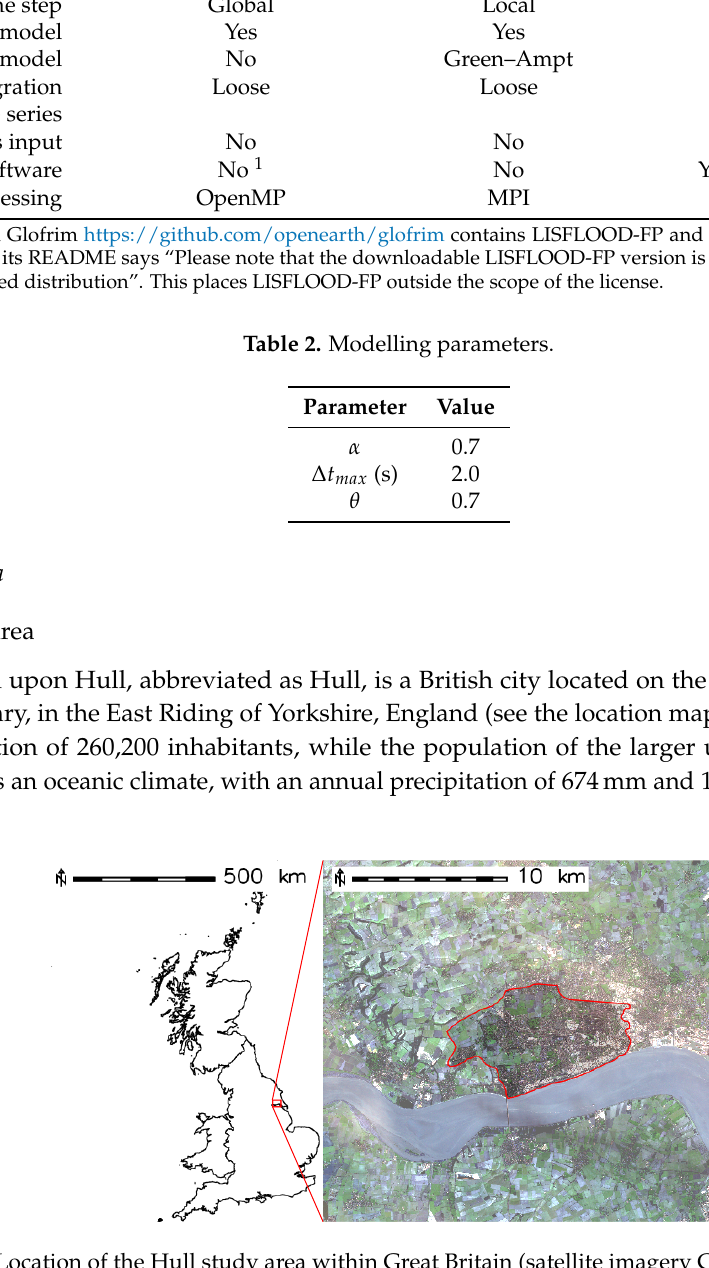
Figure 1. Location of the Hull study area within Great Britain (satellite imagery Copernicus Sentinel 2016)